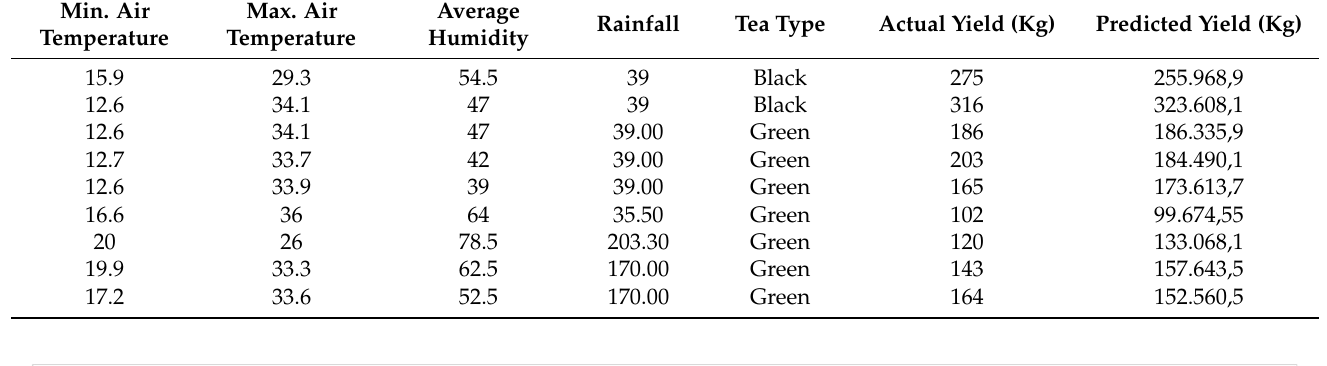
Table 5. An overview of the test data.